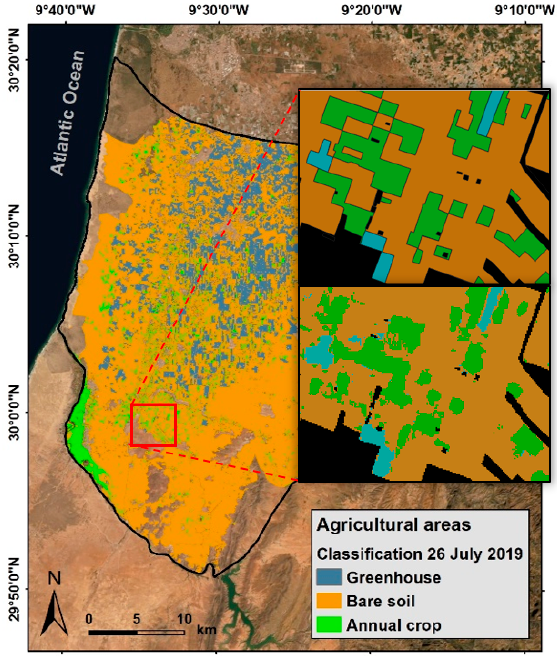
Figure 4. Difference of the pixel-based classification and the vector dataset by CRTS.